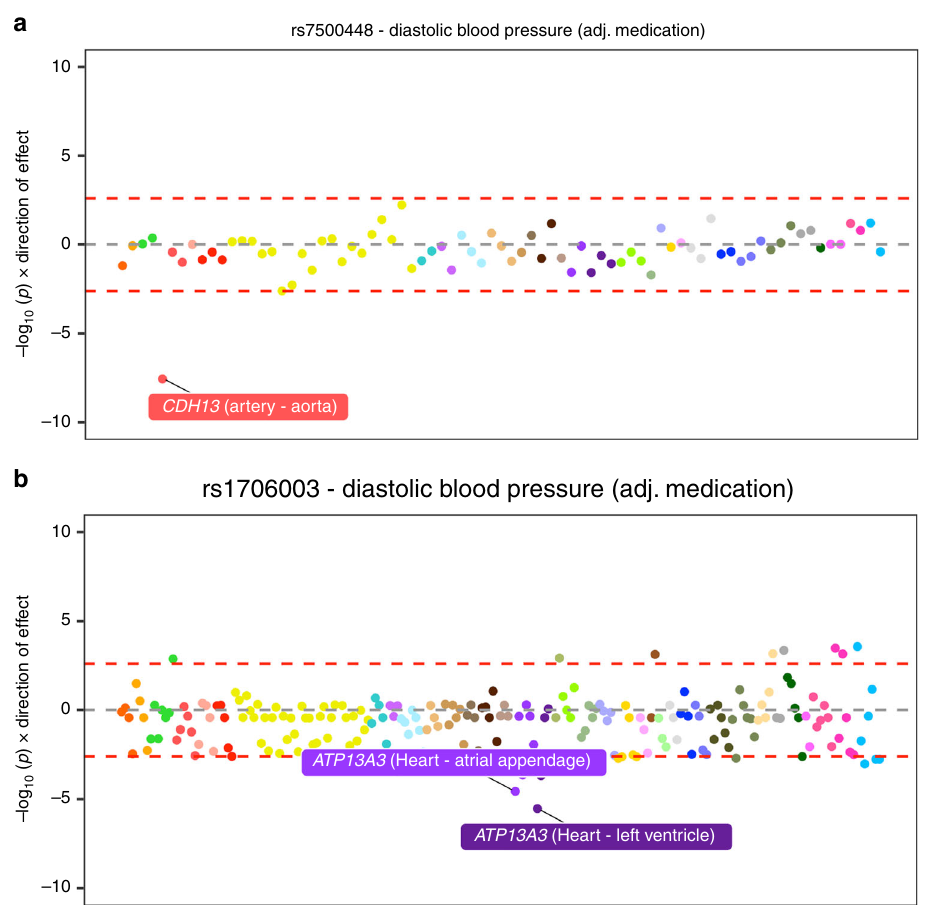
Fig. 7 Miami plots illustrating cross-tissue fi ndings at diastolic blood pressure associated loci. Miami plots between all genes whose expression is in fl uenced by proximal SNPs detected by GWAS of diastolic blood pressure (DBP). Points on these plots represent the association between all genes within a 1 Mb distance that these SNPs are eQTL for. Points are coloured in line with those used by GTEx to distinguish tissue types. a rs7500448 was strongly associated with DBP based on CDH13 expression derived from aorta tissue, and b rs1706003 was strongly associated with DBP using ATP13A3 expression data also derived from heart